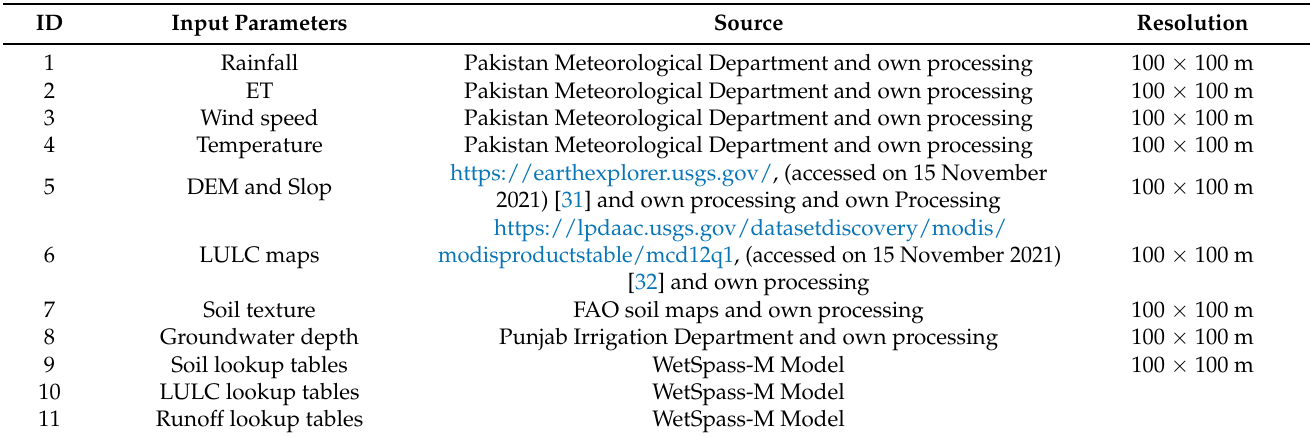
Table 1. Input parameters and source for WetSpass-M model.